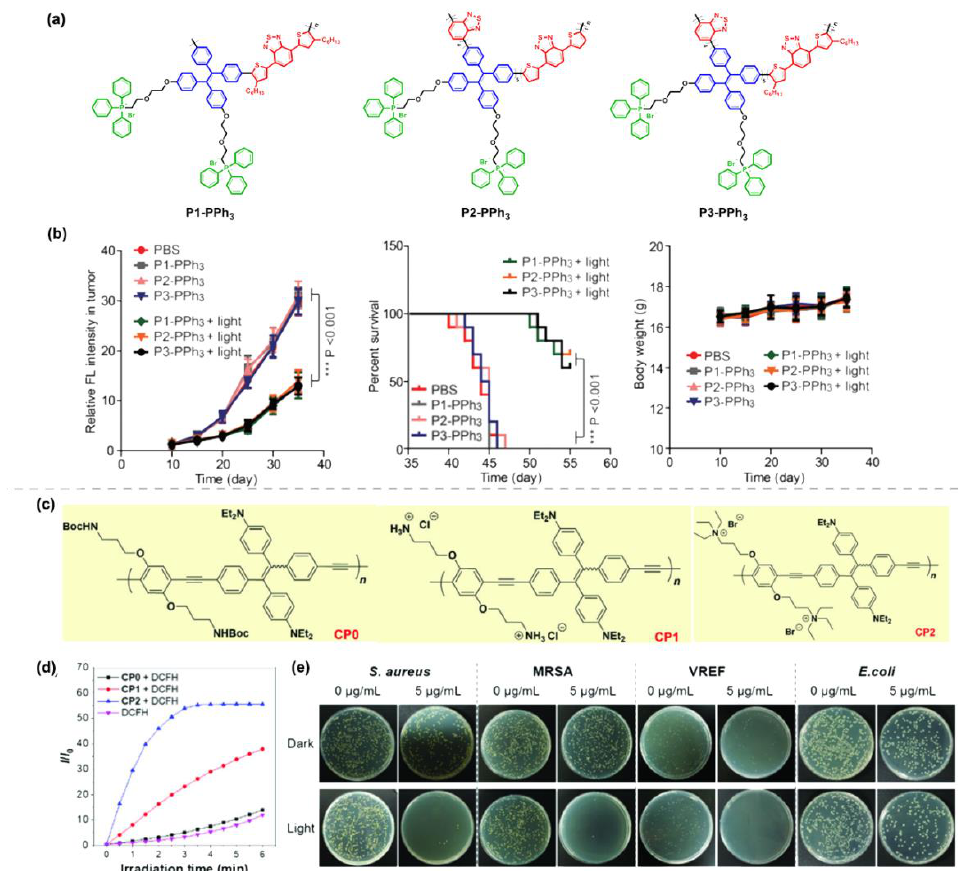
Figure 12. ( a ) The chemical structures of P1-PPh 3 , P2-PPh 3 and P3-PPh 3 . ( b ) In vivo PDT effects based on the three materials. Reprinted with permission from Ref. [63]. 2020, Springer Nature. ( c ) The chemical structures of CP0-CP2. ( d ) The ROS generation ability of the three polymers. ( e ) Photographs of biocidal activity of CP2 treated S. aureus , MRSA, VREF, and E. coli in darkness or upon white light irradiation. Reprinted with permission from Ref. [72]. 2021, Wiley-VCH.